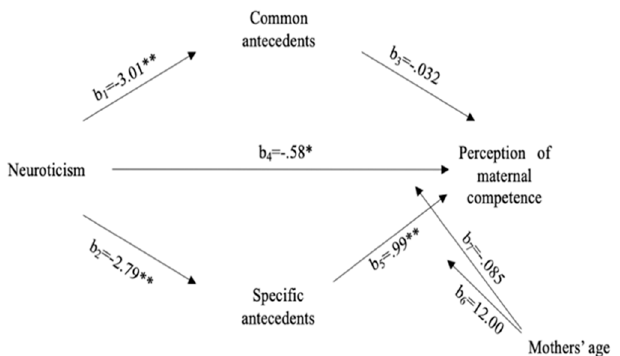
Figure 1. Mediation model. Standardized effect coefficients are reported. Common antecedent